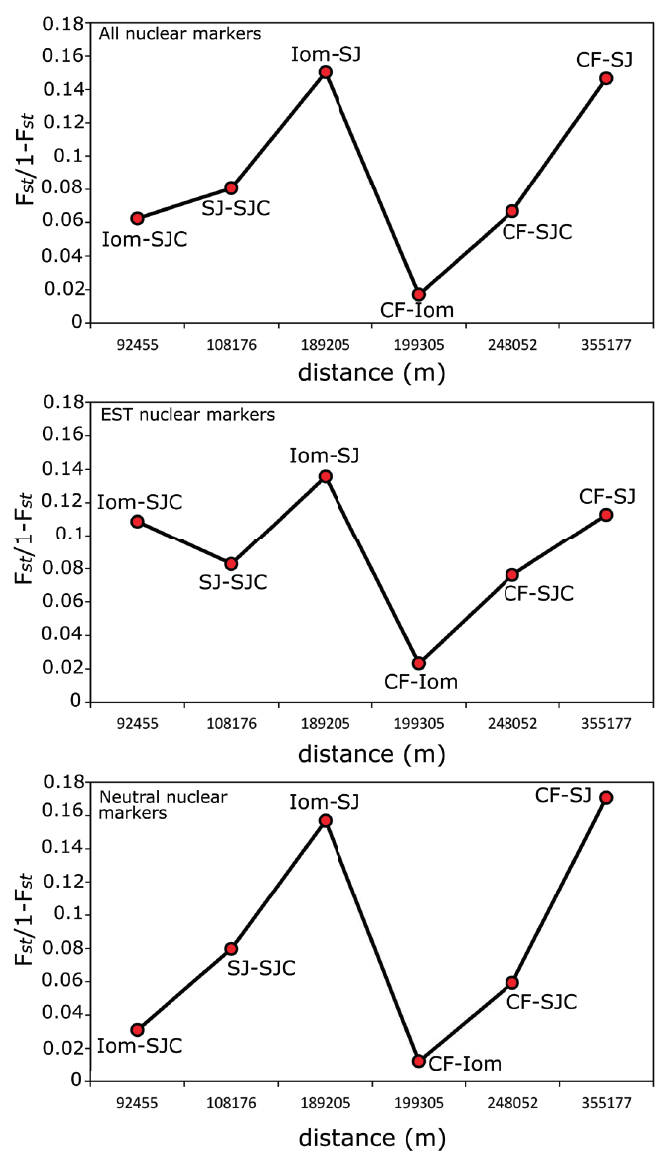
Figure 3. Plot of pairwise F /1- F estimations ST ST against the pairwise geographic distance for forest fragments of C. xanthocarpa , based on nuclear microsatellite